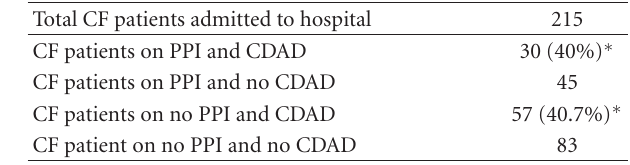
Table 1: Positive C. di ff tests for inpatient pediatric patients. Table 2: CDAD in CF patients with/without PPI